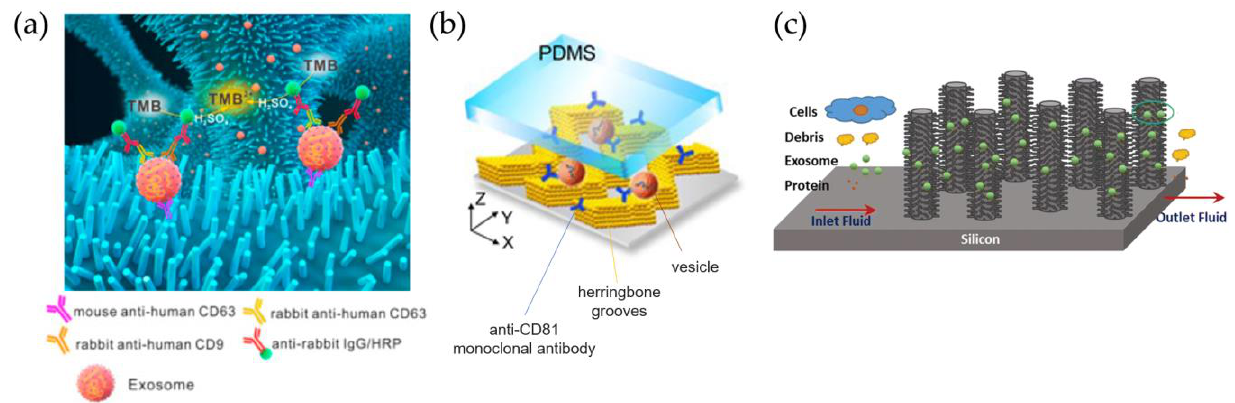
Figure 5. Immunoaffinity capture inside microfluidic devices. ( a ) ZnO nanowires fabricated inside channels for the specific capture of CD63-positive sEVs, modified from [109]; ( b ) colloidal structures arranged in a herringbone configuration inside the microfluidic channel, modified from [123]; ( c ) ciliated silicon nanorods capable of discriminating sEVs from cell debris [113].